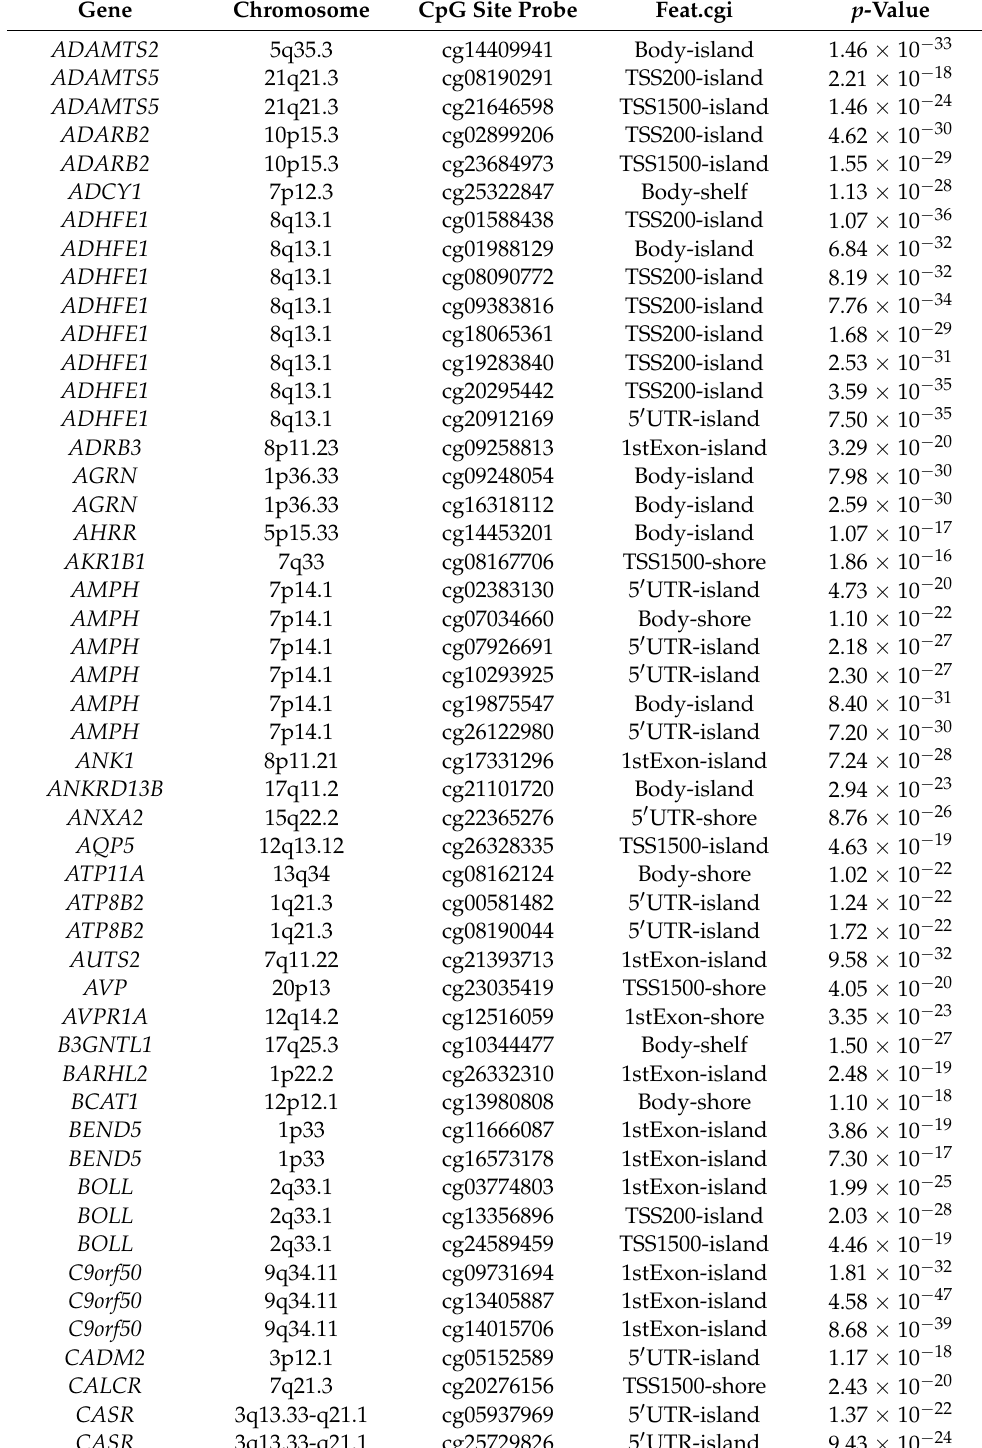
Table 1. List of the top 50 CpG sites that were most highly differentially methylated between tumor and control samples, and the genes and DNA methylated regions they map